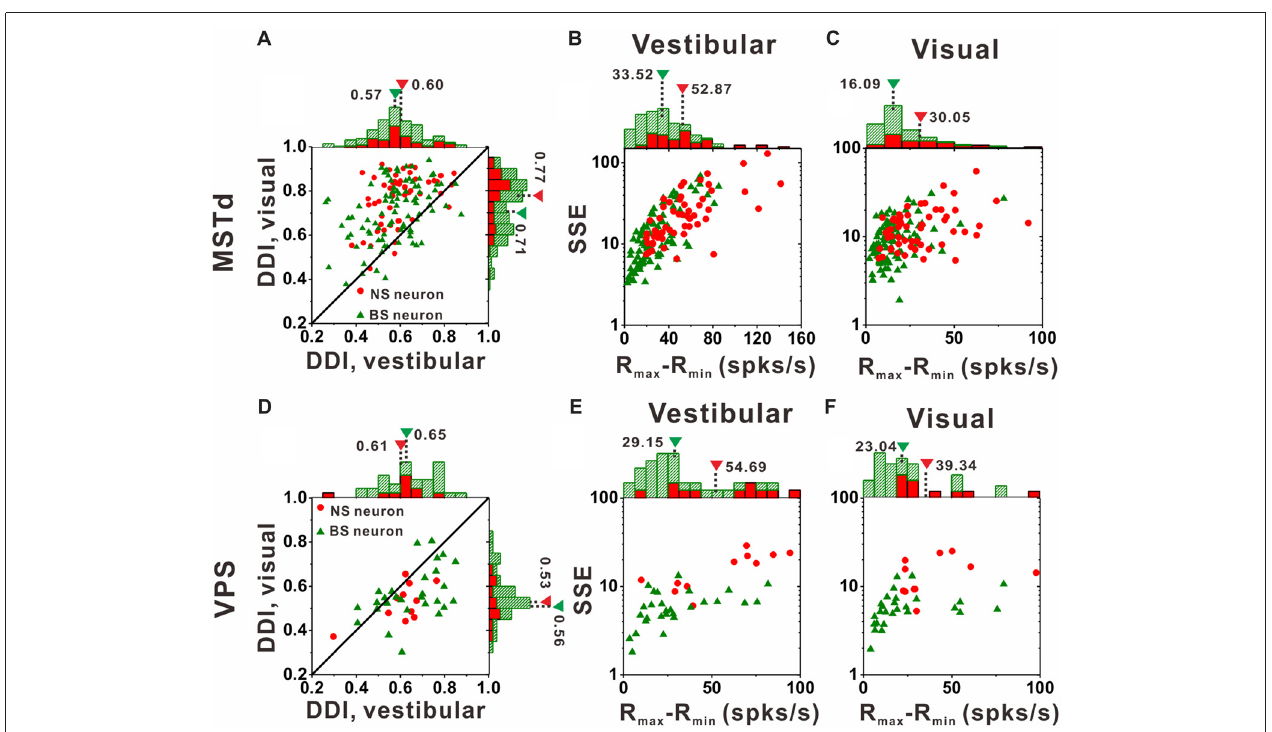
FIGURE 7 | Tuning strengths to the NS (red) neurons and BS (green) neurons in areas MSTd (upper panel) and VPS (lower panel) under the vestibular and visual conditions. (A) Scatter plots of direction discrimination index (DDI) values for the vestibular (abscissa) and visual (ordinate) conditions, respectively. (B,C) Scatter plots of each neuron’s firing rate variabilities (standard deviation, SD) over the maximum difference of the neuron’s firing rates (R max − R min ) for the vestibular condition (B) and the visual condition (C) . The histograms on the top and right show the marginal distributions. (D–F) Same as (A–C) respectively but for area